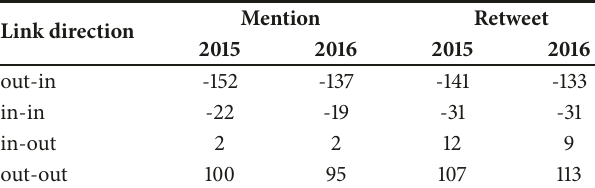
Table 5: Z-Scores of the assortativities of the different aggregated networks with respect to 500 realizations of the directed configura- tion model.